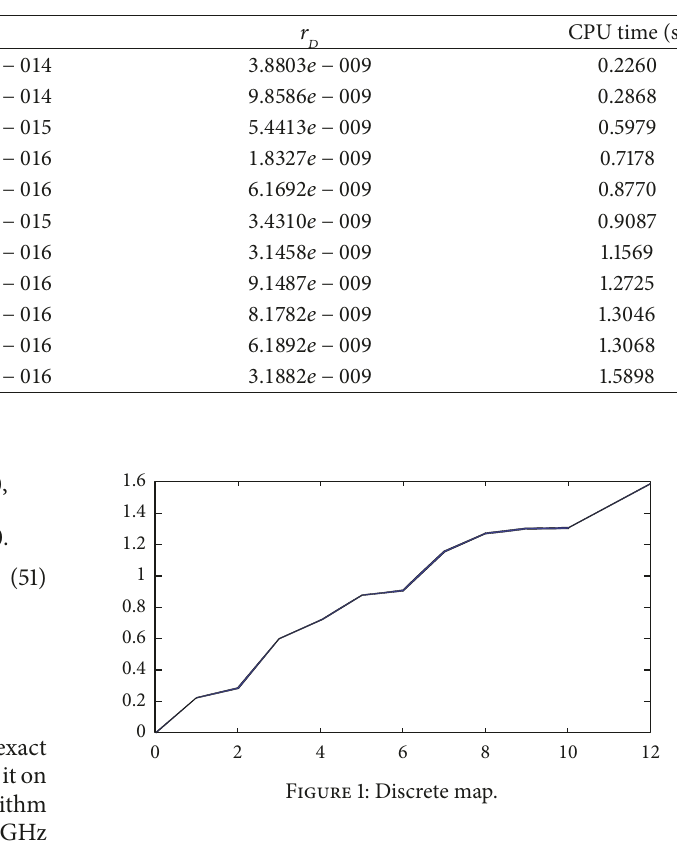
Table 1: Objective function is random matrix.